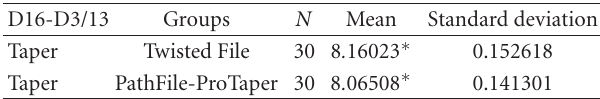
Table 2: Mean percent di ff erence and standard deviation from .08 nominal taper in the middle-cervical third among 2